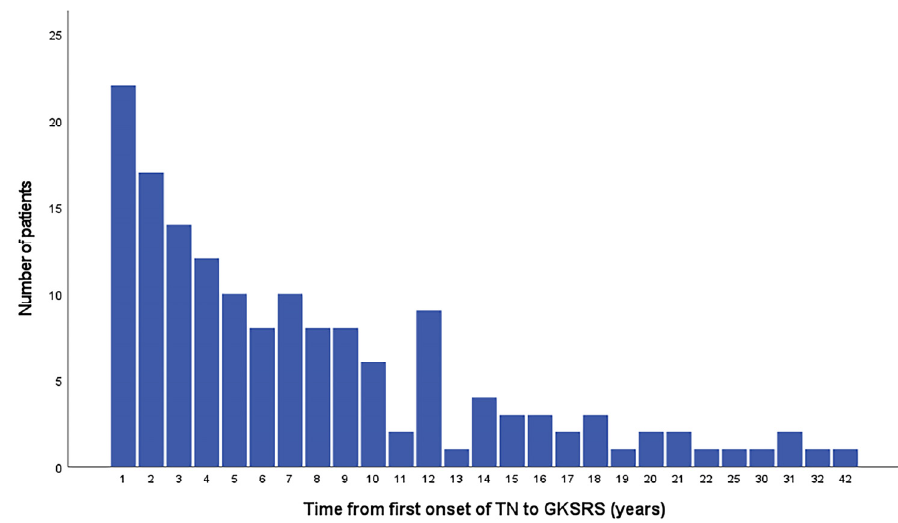
Figure 2. Time interval from the first onset of trigeminal neuralgia to GKSRS. Table 3. Trigeminal Neuralgia Pain Characteristics.